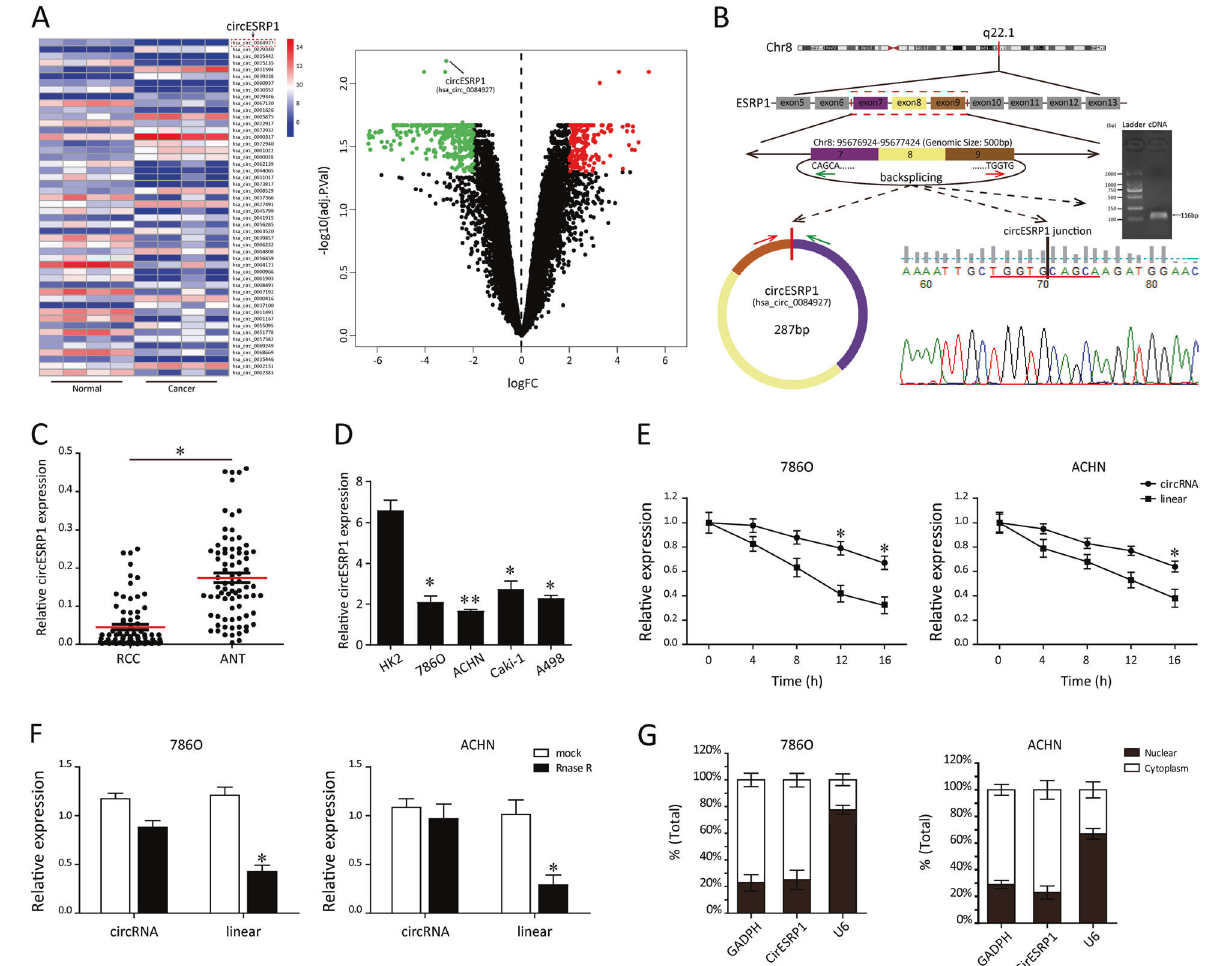
Fig. 1 circESRP1 is downregulated in the ccRCC tissues and cells. A The heatmap and volcano plot of circRNA pro fi les in RCC and normal tissues in the dataset from the GEO database (GSE100186). The variation in RCC-related differentially expressed circRNAs from GSE65071 was compared and illustrated. B Schematic diagram illustrated the formation of circESRP1. The RT-PCR product and back-splicing junction of circESRP1 were validated by agarose gel electrophoresis and Sanger sequencing. C qRT-PCR analysis showed the expression levels of circESRP1 in ccRCC tissues were signi fi cantly lower than that in adjacent normal kidney tissues. D Relative expression fold changes of circESRP1 in ccRCC cell lines were screened by qRT-PCR. 786O, ACHN, Caki-1, and A498 exhibited lower circESRP1 expression, while HK2 was circESRP1-high-expressed. E The transcript half-life of circESRP1 and linear ESRP1 in 786O and ACHN cells treated with transcription inhibitor Actinomycin D was analyzed by qRT-PCR. F RNase R was administrated to the extracted RNA to detect the relative expression of circular form (circESRP1) and the linear form (ESRP1 mRNA). G Levels of circESRP1 in the nuclear and cytoplasmic fractions of 786O and ACHN cells. Data are the means ± SEM of three independent experiments. * P < 0.05; ** P < circESRP1 transcription. The bioinformatics tools predicted on JASPAR (http://jaspar.genereg.net/) and PROMO 3.0 website validated that CTCF shared with the binding sites with the promoter region of ESRP1 (Fig. 3C). Simultaneously, targeting the two potential sites, the ChIP-PCR and agarose gel electrophoresis assays were performed. The result demonstrated that the second site ( − 257 to − 239) might effectively combine with the CTCF antibody (Fig. 3D). Furthermore, the WT and MUT sequences of ESRP1 promoter region ( − 257 to − 239) targeting the second predicted sites were constructed, and the results of luciferase reporter assay proved the WT rather than MUT of this region could combine with the CTCF, suggesting the CTCF-mediated activation for ESRP1 transcription (Fig. 3E). The biogenesis of circular RNAs or linear ones can derive from the same pre-mRNA through the competition between back- splicing and canonical splicing [25]. Hence, we further investigated the relationships between the CTCF expression and circESRP1, or ESRP1 mRNA levels. As shown in Fig. 3F, there was no signi fi cant